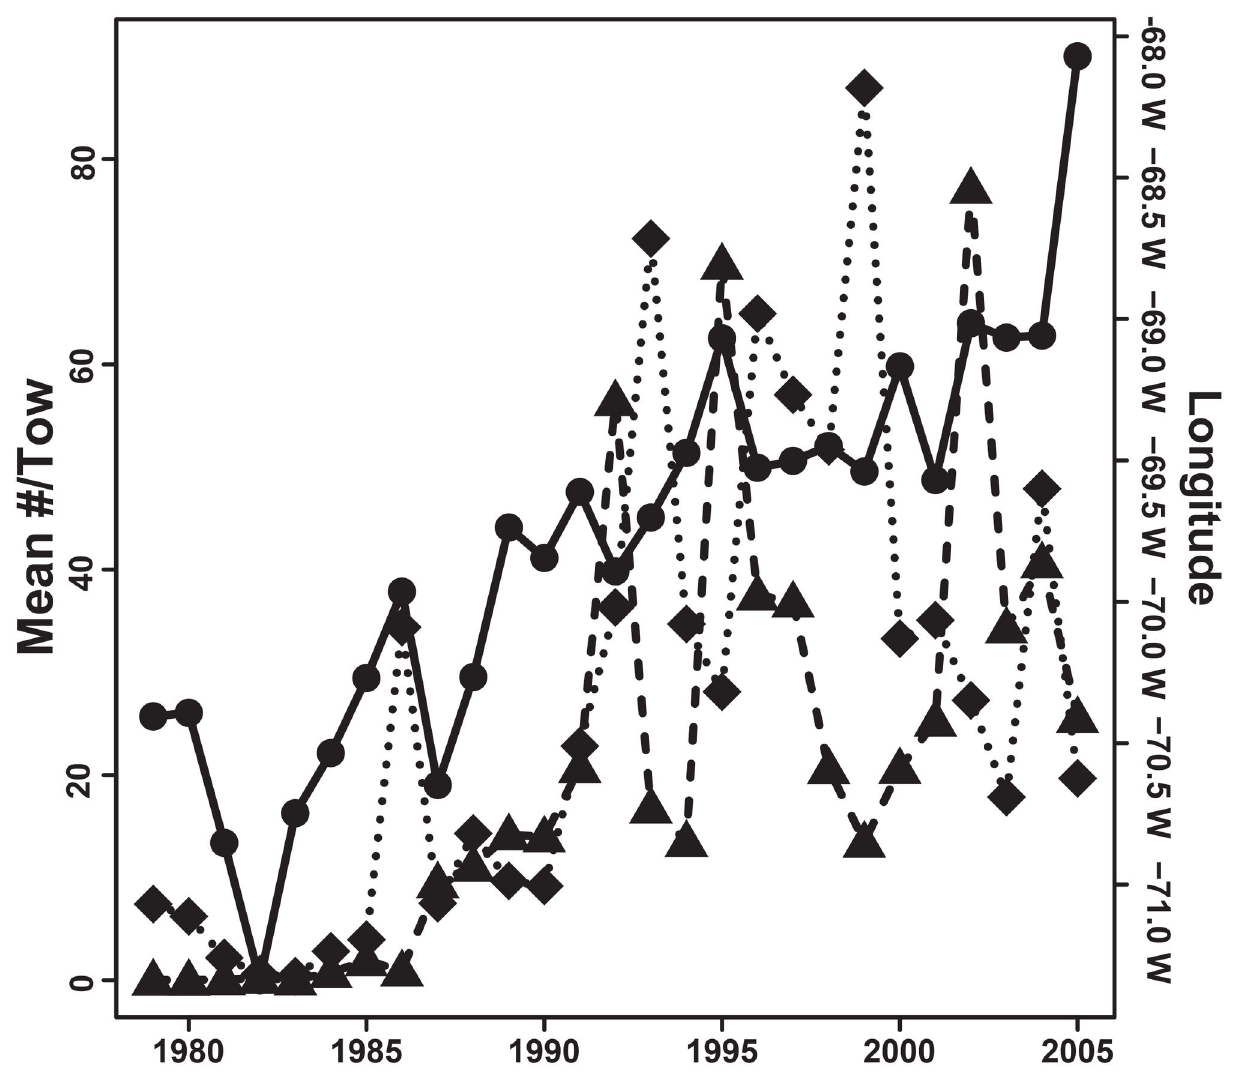
Figure 3. Average number of Atlantic herring/tow and position of Atlantic bluefin tuna schools. Each bluefin tuna point represents a weighted mean of surface schools (solid black circles) and is correlated with an increase in herring/tow on Georges Bank during the spring (solid black triangles) and fall trawl survey (solid black diamonds). Atlantic herring data represented as the mean herring per tow from the (National Marine Fisheries Service) autumn bottom trawl survey for survey strata on George’s Bank.